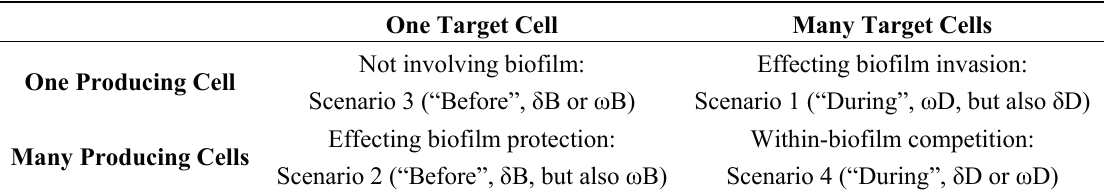
Table 2. Scenarios of antibacterial action based on the size of involved populations, presented as a 2 × 2 matrix. Numbers refer solely to the order of discussion in the main text. Parentheticals refer to the state of target organisms vis-à-vis biofilm status; see